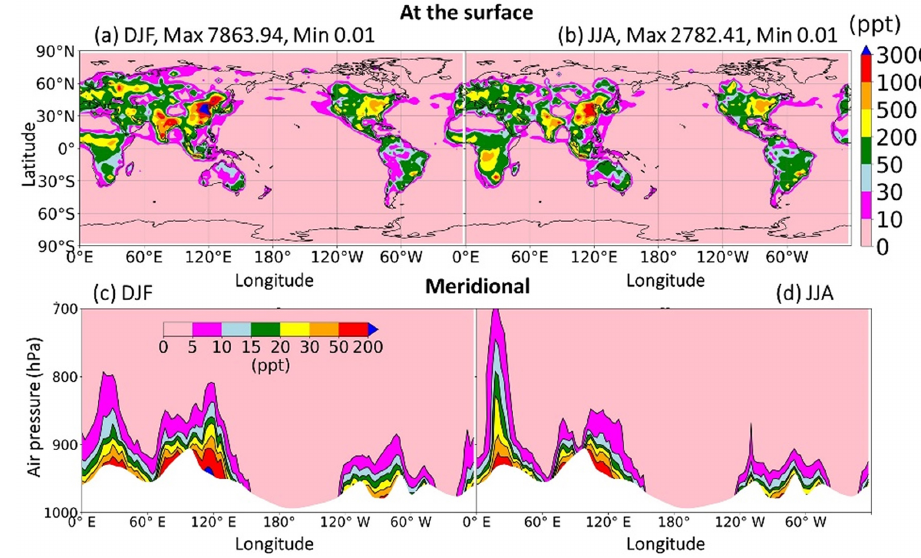
Figure 11. Distribution of HONO levels at the surface (a–b) and meridional mean (c–d) .